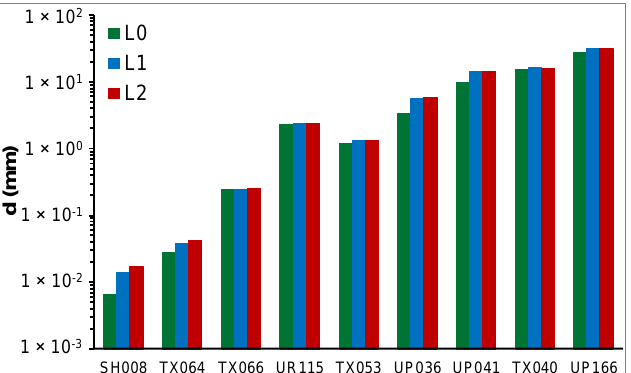
Table 4. Maximum accelerations, displacements, relative displacements of the gravity centers and maximum relative displacements at the corner isolators for the selected seismic events. Figure 16. Maximum absolute displacement between the gravity centers at L0, L1 and L2 for the considered seismic events.